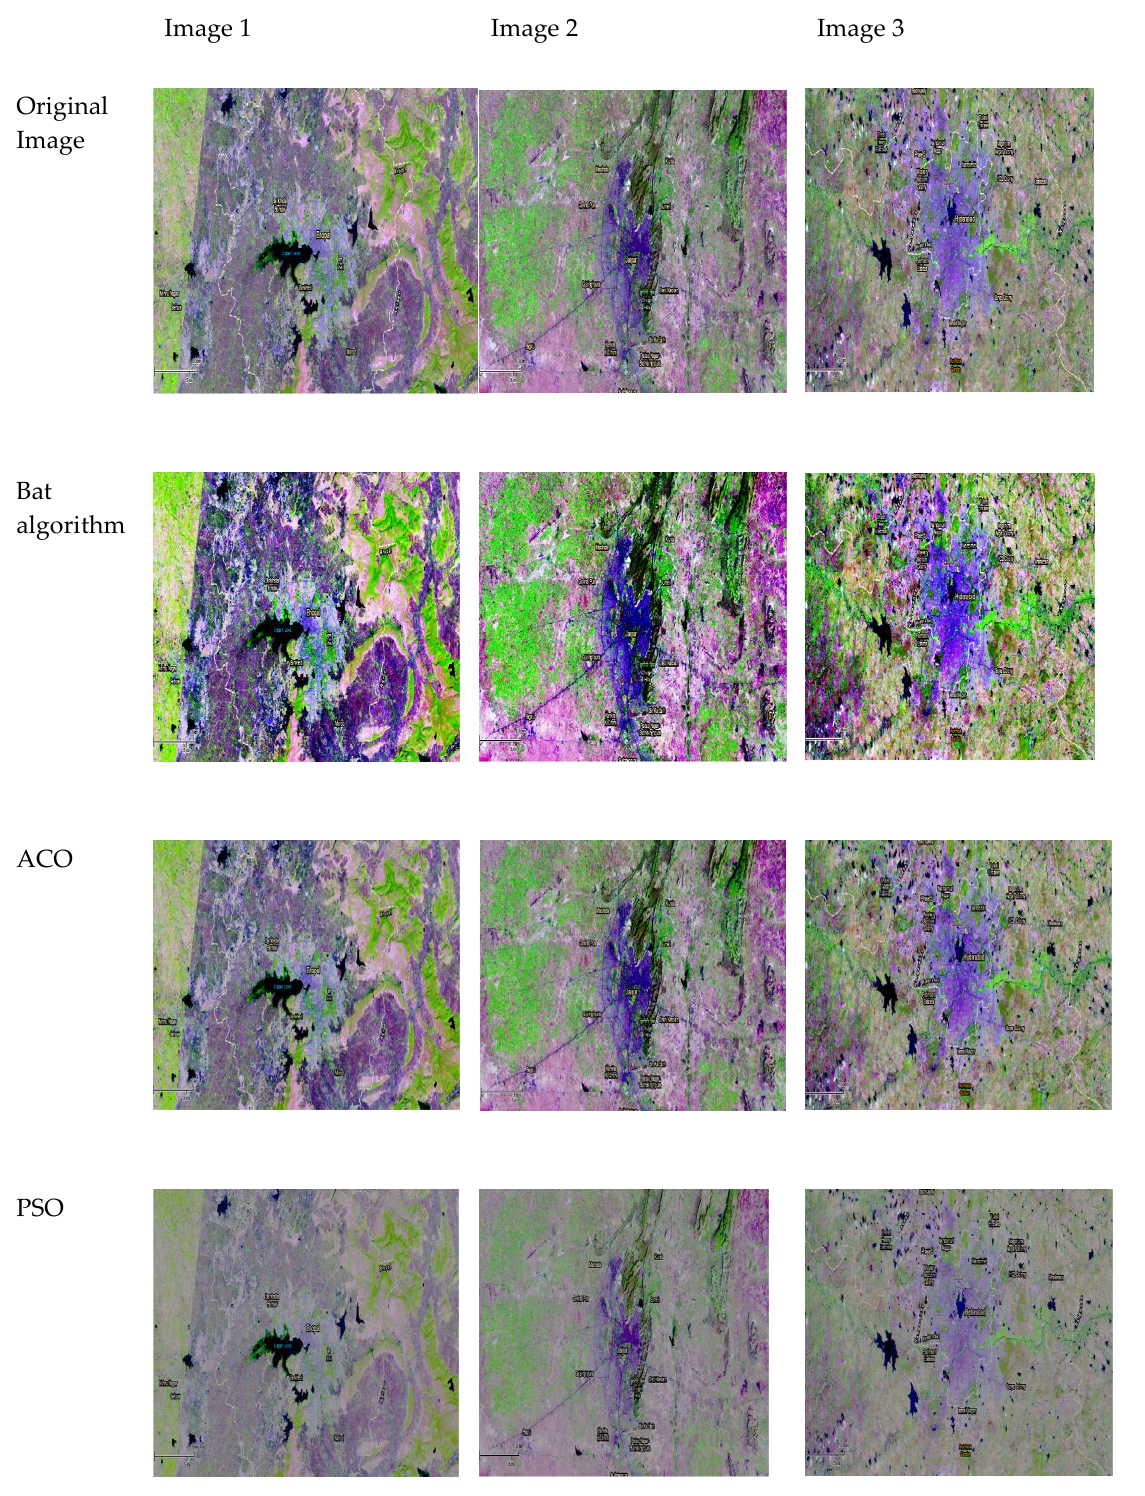
Figure 3. Enhanced outputs for di ff erent